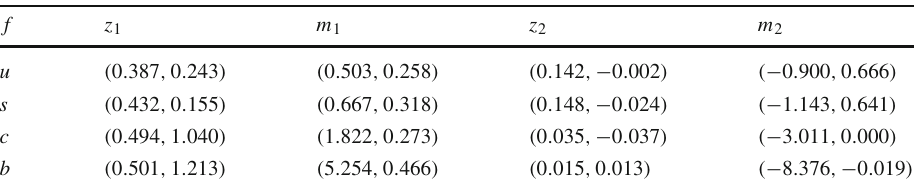
which is from Ref. which are FLAC 2019 averages [91] and f η c [92]. The relative deviations from experimental values are given by